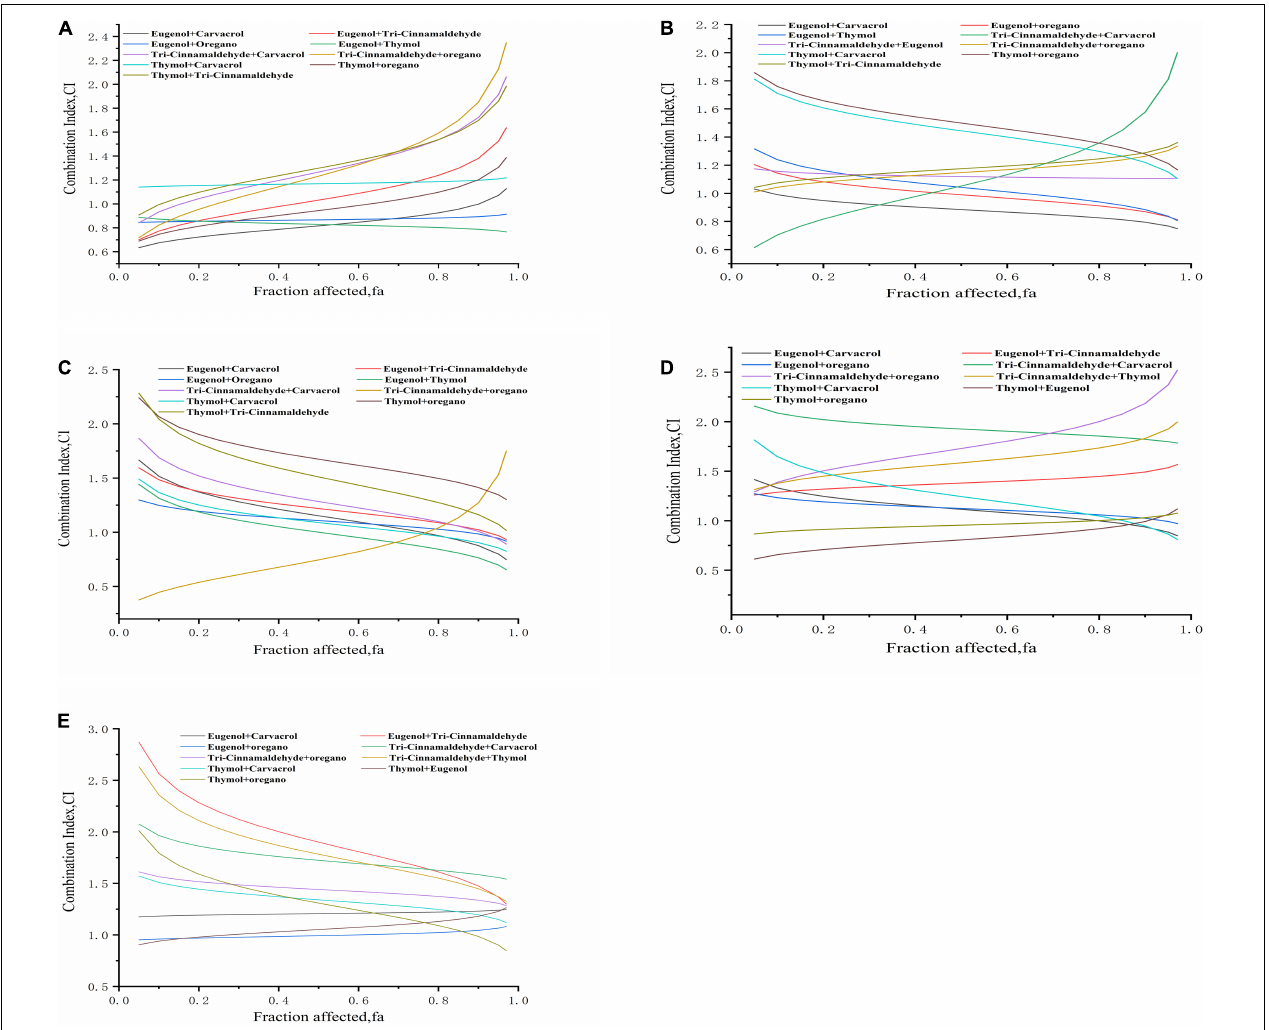
FIGURE 4 | Evaluation of combined effects of binary natural antimicrobials combinations based on CI model. Combination index plot (fa–CI plot) for pairwise drug combinations: (A) Salmonella pullorum BNCC 19945; (B) Klebsiella pneumoniae BNCC 102997; (C) K. pneumoniae Sample 208G28; (D) Escherichia coli BNCC 336435; (E) E. coli Sample